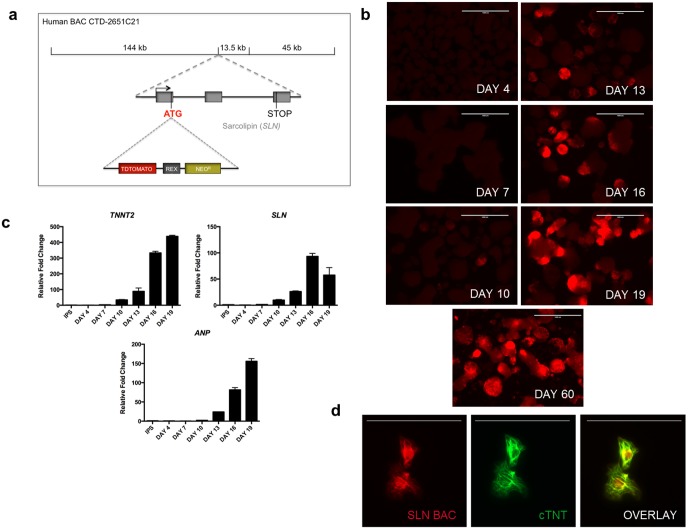
BAC transgene and expression in hiPSC-derived cardiomyocytes.(a) Schematic of recombineered BAC containing a tdTomato-Rex1-NeoR cassette. (b) tdTomato fluorescence in differentiating EBs appeared at Day 10 of differentiation and increased over time, lasting up to 60 days. Scale bars, 1000 µm. (c) qPCR of differentiating EBs showing timeline of expression of cTNT, SLN, and ANP consistent with the appearance of red fluorescence. (d) Dissociated red+ cells were positive for cTNT by immunofluorescence. Scale bars, 100 µm.